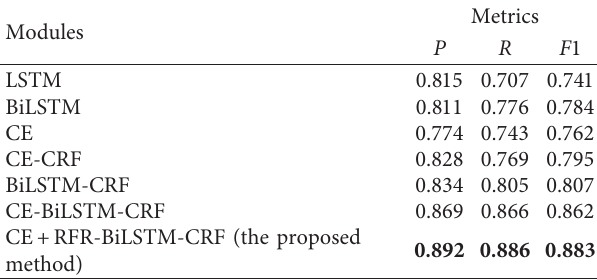
Table 2: Performance comparison of different modules on EPE- MR dataset (CE: character embedding; RFR: radical feature